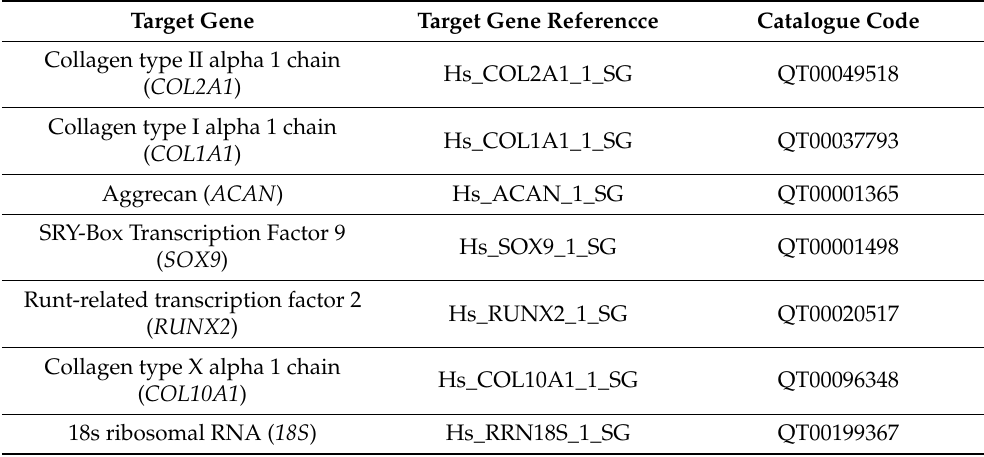
Table 2. List of gene transcripts analysed by qRT-PCR. Qiagen QuantiTect validated primers used to analyse the expression levels of target